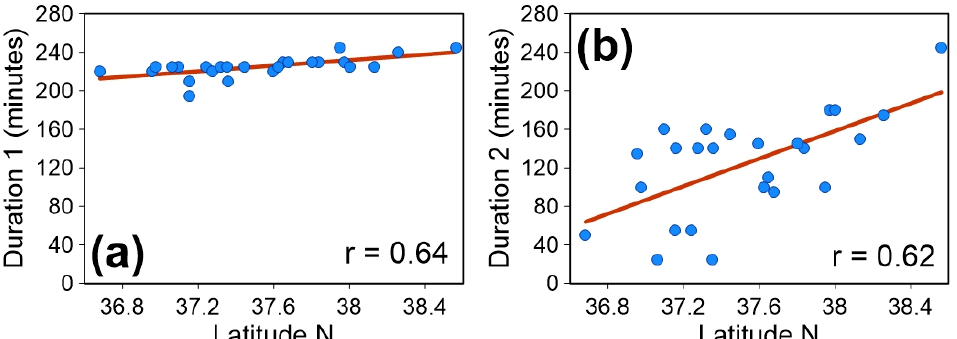
Figure 5. ( a ) Duration of pressure perturbations triggered by the first passage of the shockwave plotted versus latitude of the stations; ( b ) duration of pressure perturbations triggered by the second passage of the shockwave plotted versus latitude of the stations.